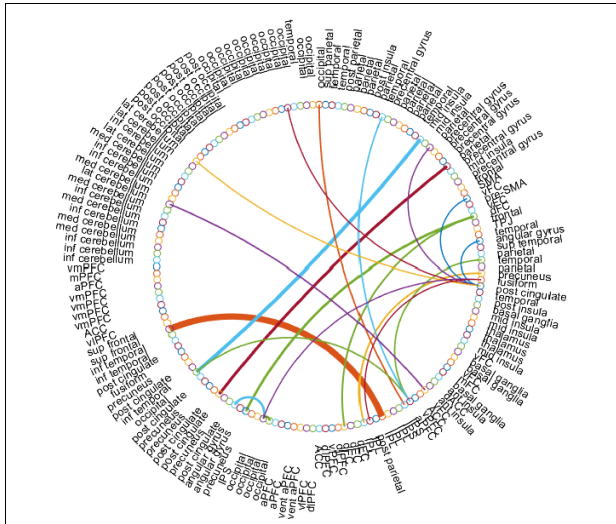
FIGURE 6 | The most discriminative edge features of the BHM- (cid:127) involved in the ASD classification task by using a t -test ( p < 0.001). This figure is created by the circularGraph tool, which is designed by Paul Kassebaum and can be downloaded from http://www.mathworks.com/matlabcentral/fileexchange/ 48576-circulargraph.